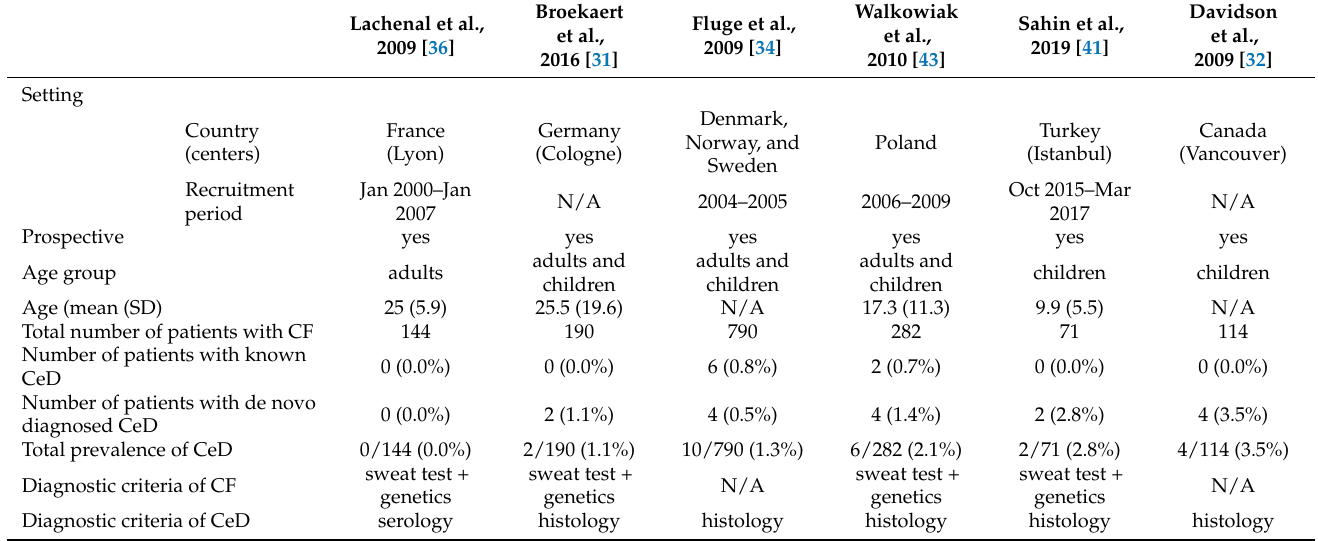
Table 1. CeD prevalence from consecutive studies (SD: standard deviation, CF: cystic fibrosis, CeD: celiac disease). Lachenal et al.,